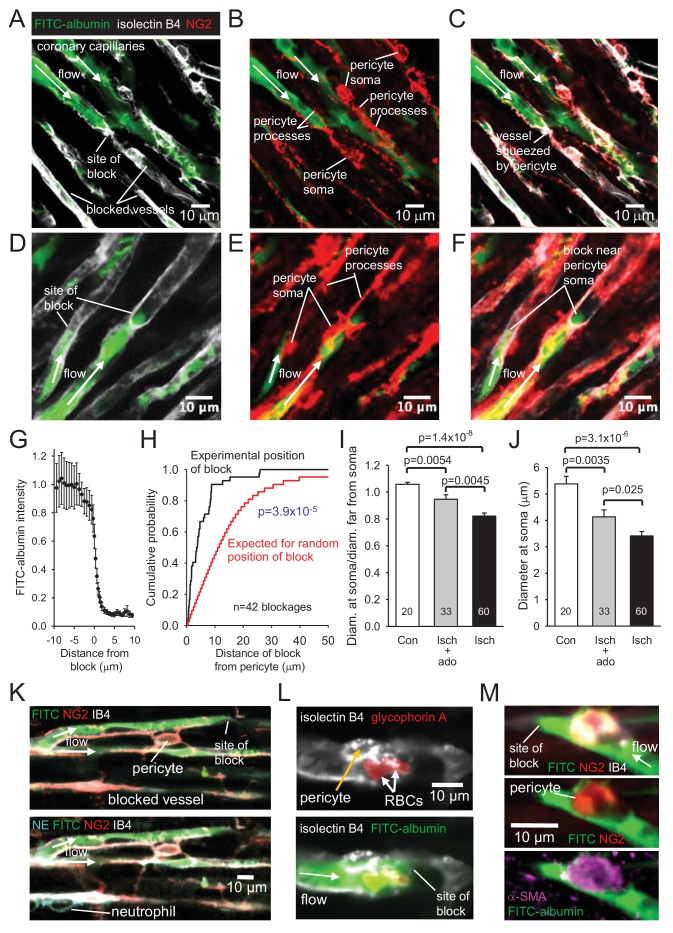
No-reflow reflects blockage by pericyte constriction.(A) Image of perfused and non-perfused capillaries in post-ischaemic left ventricle. Isolectin B4 labelling (white) defines positions of all vessels, while FITC-albumin labelling (green) shows vessels that are perfused. Bottom left capillary is completely non-perfused; top green capillary is fully perfused; lower green capillary is blocked halfway across the image. (B, C): NG2-labelling of pericytes (B) and merge (C) of the images (A) and (B) show pericyte processes constricting vessel at block site. (D–F) Another example set of images as in (A–C), showing two capillaries blocked near pericyte somata. (G) Normalised intensity of (background-subtracted) FITC-albumin (green) labelling along the centre of the capillary lumen across 20 block sites. (H) Cumulative probability distribution for the distance from capillary blockage sites to the nearest pericyte soma (black) and for the position expected (see Figure 3—figure supplement 1) if blocks occurred at positions independent of pericyte locations (significantly different, p=3.9×10−5). Comparing the experimental distribution with a theoretical distribution increasing linearly to one at a distance of 30 μm (see Image Analysis in Materials and methods) also showed a significant difference (p=7.6×10−8). (I) Ratio of capillary diameter at pericyte somata to the diameter at positions ~ 10 μm upstream after ischaemia, after ischaemia with adenosine (ado), and for sham-operated hearts (Con). (J) Diameter at pericyte somata after ischaemia, after ischaemia with adenosine, and for sham-operated hearts (Con) (all pericyte locations were measured, not just those associated with capillary blockages, for which the mean diameter after ischaemia was smaller: 3.19 ± 0.24 μm, n = 30). (K) Capillary blockage in an area of the heart with a neutrophil (labelled for neutrophil elastase, NE, bottom left) present outside the capillaries. (L) Pericyte (labelled with isolectin B4) near a blockage constricting a vessel with two red blood cells (RBCs, labelled for glycophorin A) trapped in the constriction. (M) Blockage-associated pericyte (labelled for NG2) that also labels for α-SMA. Numbers on bars are of pericytes. Data are mean ± s.e.m. P values in I-J are from Mann-Whitney tests and are corrected for multiple comparisons.